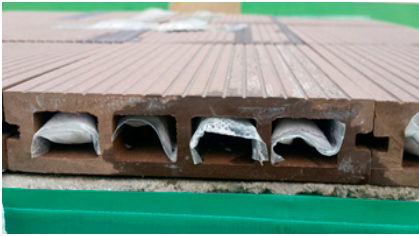
Figure 2. Packed PCM placed within the hollows of the wood-plastic composite (WPC) plate.